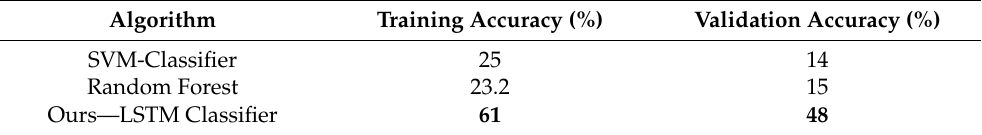
Table 10. Comparison with other machine learning algorithms.